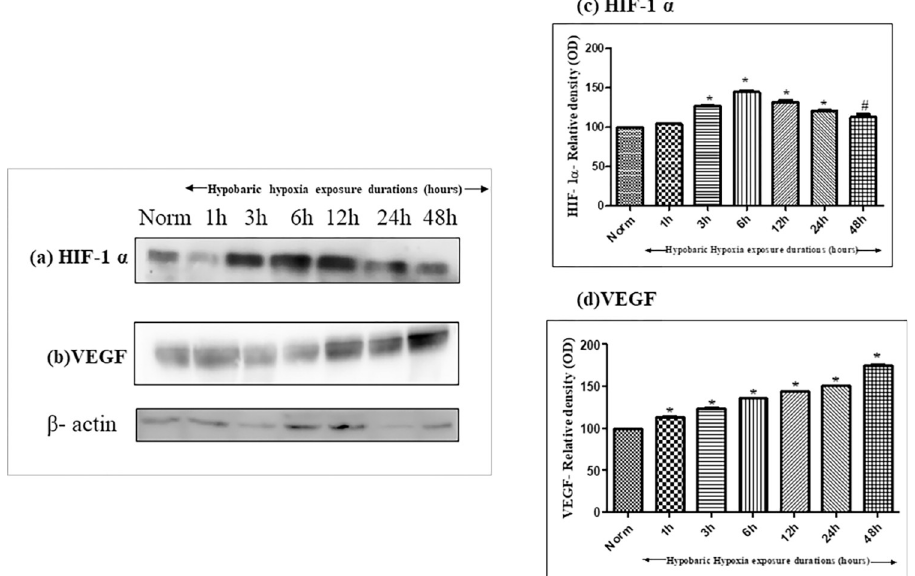
Fig 4. Effect of hypobaric hypoxia on protein expressions of (a) Hypoxia inducible factor- 1 α (HIF-1 α ) and (b) Vascular Endothelial Growth Factor (VEGF) in kidneys of rats exposed to different hours of hypobaric hypoxia (1h,